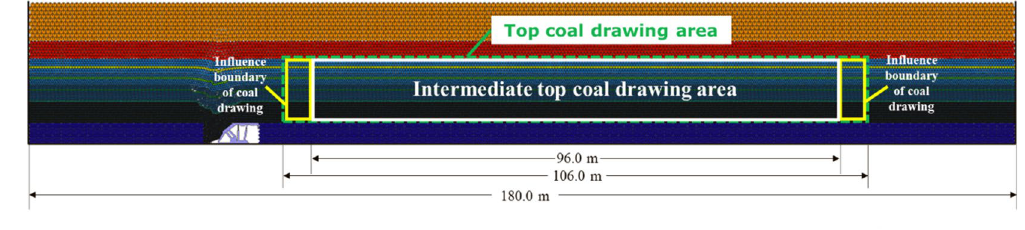
Figure 12. Schematic diagram of the total top coal caving area in the statistics of top coal caving along the strike direction of working face.